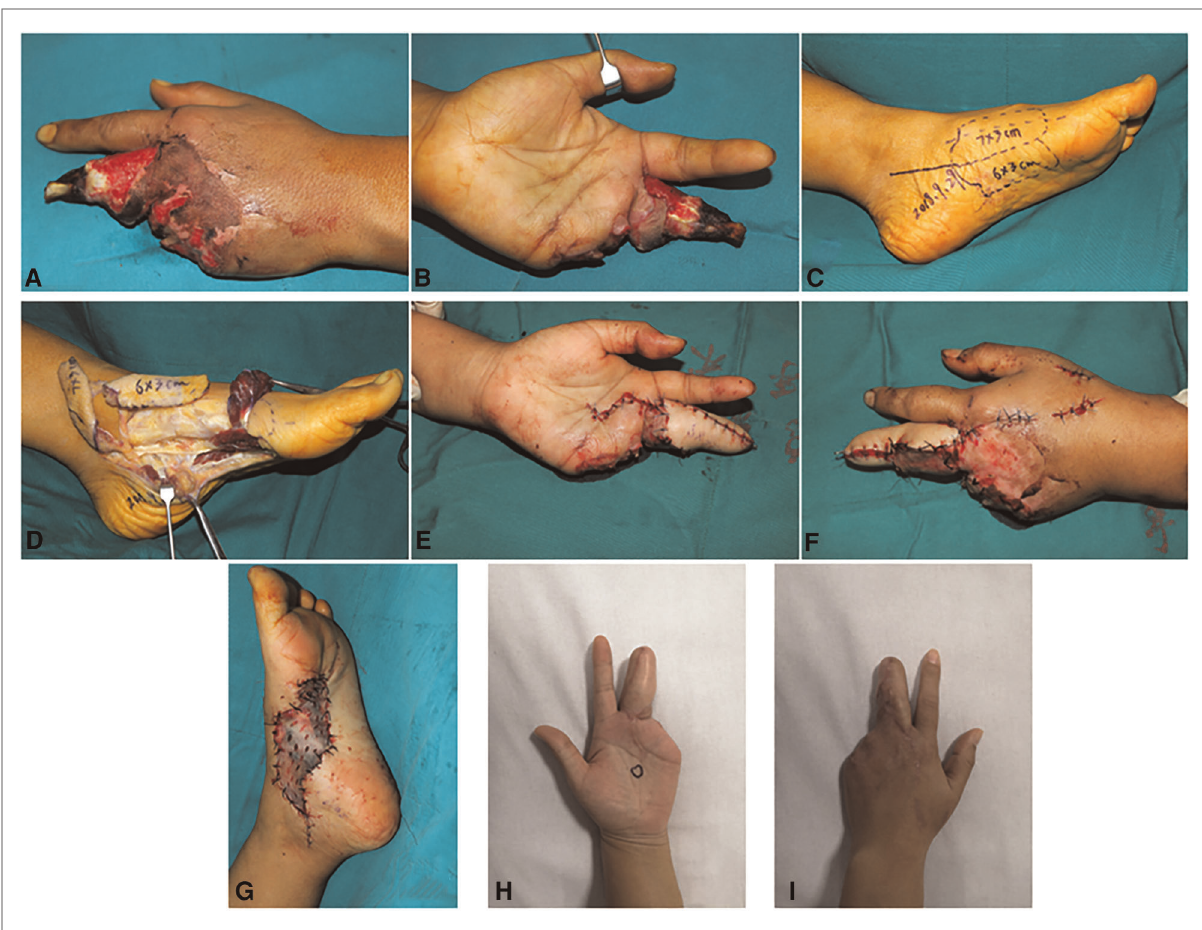
FIGURE 3 Case 2: Pre-operative view of the defect ( A,B ). A multipage MPAP fl ap (7×3 cm 2 and 6×3 cm 2 ) designed according to the size of the defect is marked ( C ). A two-lobulated MPAP fl ap is harvested ( D ). The MPAP fl ap is transferred to the defect in the fi nger ( E,F ). Full-thickness skin grafting is performed at the donor site ( G ). Final appearance at 6 months of follow-up ( H,I